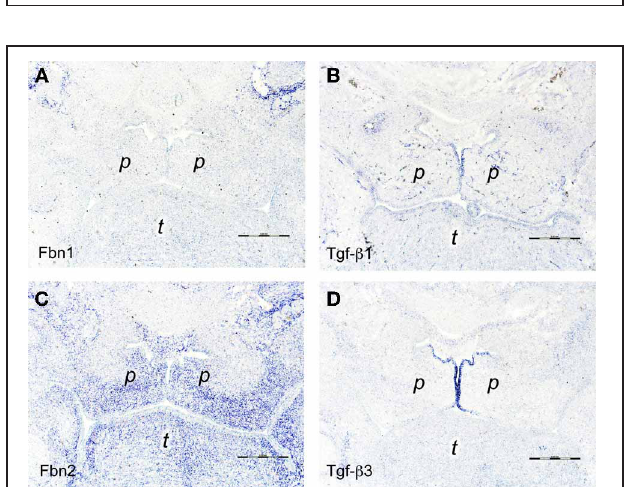
FIGURE 2 | In situ hybridizations on frontal sections through E13.5 wildtype mouse embryo heads at the level of the posterior palate with RNA probes specific for (A) fibrillin-1 , (B) Tgf- β 1 , (C) fibrillin-2 , and (D) Tgf- β 3 . The maxillary processes in (A,B) show increased expression of fibrillin-1 and Tgf- β 1 mRNA, respectively. Note enhanced expression of fibrillin-2 in the proximal-medial mesenchyme of the palatal shelves (C) , dorsal of the epithelium positive for Tgf- β 3 mRNA (D) . Maxillary process ( mx ), palatal shelf ( p ), tongue ( t ). Bars, 250 μ m.